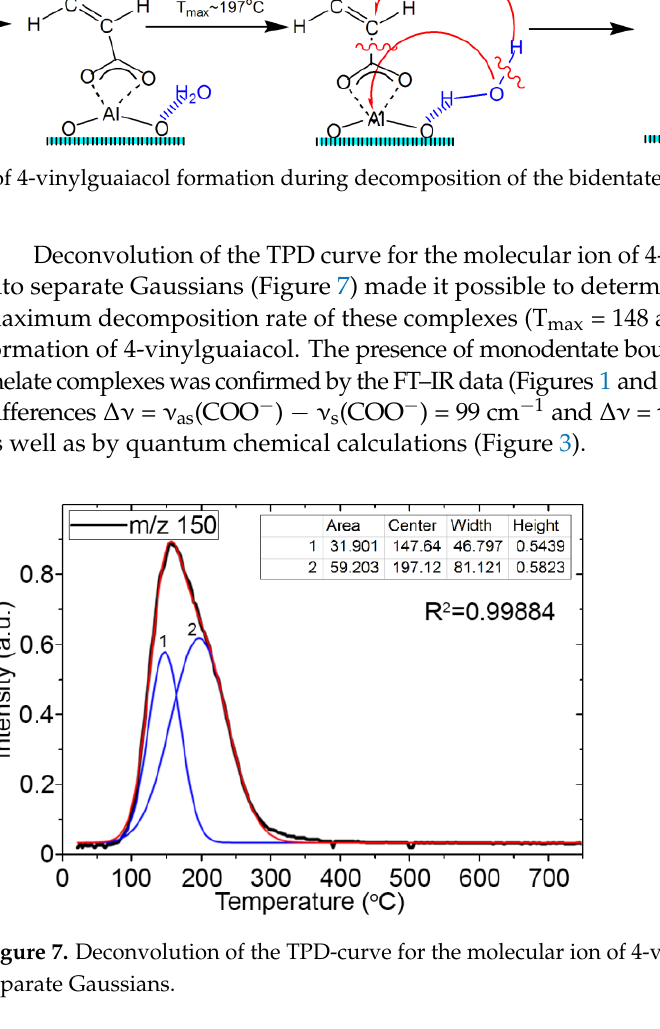
Figure 8. TPD-curves of molecular ion of methylated 4-vinylguaiacol and its fragment ions with m/z 164, 149, 138, and 121. Scheme 3. The possible way of methylated 4-vinylguaiacol formation.